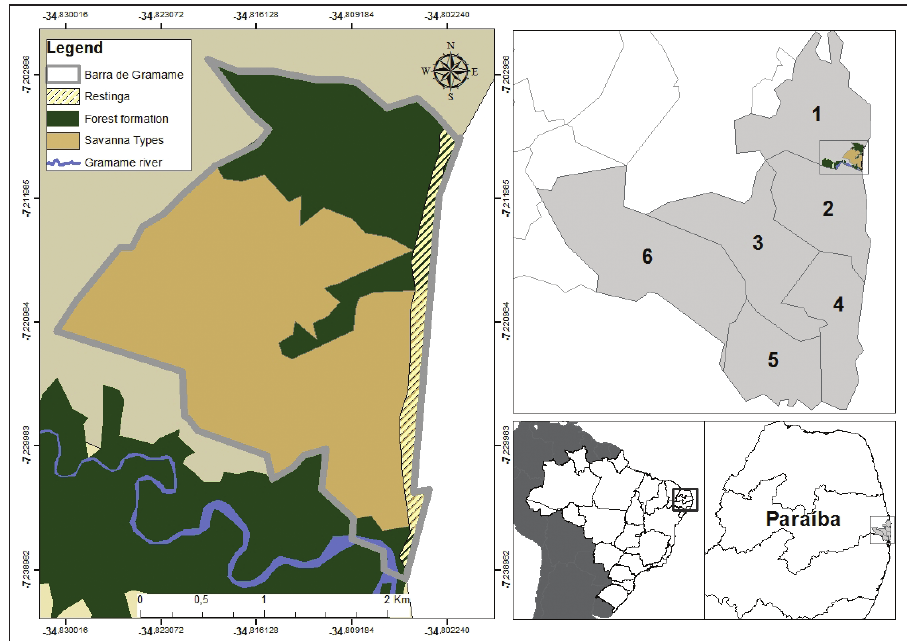
Figure 1. Schematic map showing the south coast of Paraíba state. Detail box: Barra de Gramame, located in the municipality of João Pessoa. The numbers represent the following municipalities: 1 João